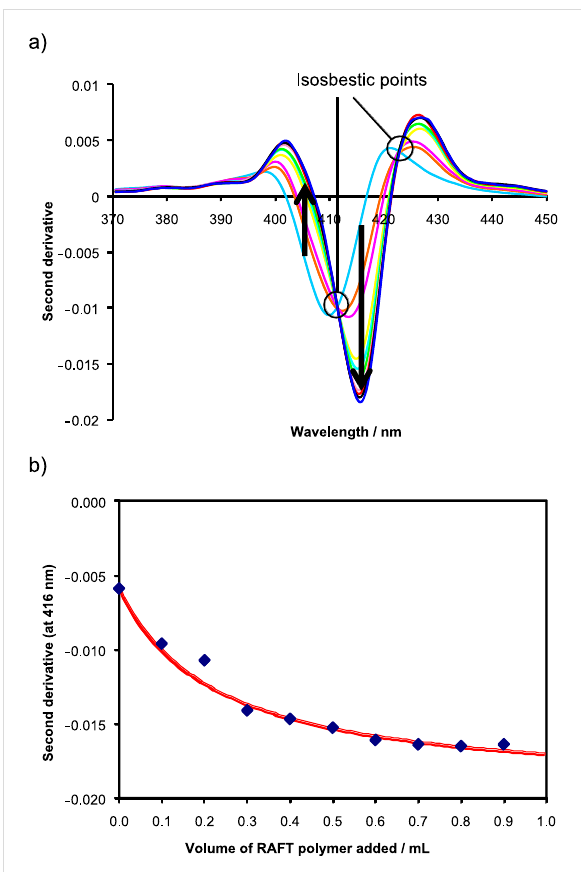
Figure 2: a) Second derivative UV–vis spectra [17-19] observed during a full titration of a stock solution of RAFT copolymer S10CH15 (6.3 × 10 − 3 mol L − 1 ) into a solution of cyt C (9.9 × 10 − 6 mol L − 1 ) in phosphate buffer at pH 7 and ionic strength of 0.15 mol L − 1 KCl. The arrows indicate increasing amounts of RAFT copolymer added. b) Plot of second derivative values at 416 nm as a function of volume (in mL) of RAFT copolymer solution added. The filled diamonds are experi- mental values, whereas the drawn curve represents the calculated isotherm for a K a of 1.6 × 10 3 M − 1 assuming 1:1 binding